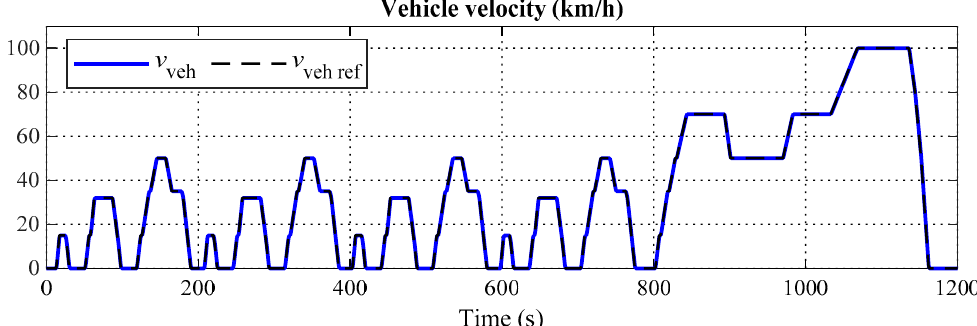
Figure 7. (Simulation) vehicle velocity following the test profile NEDC.